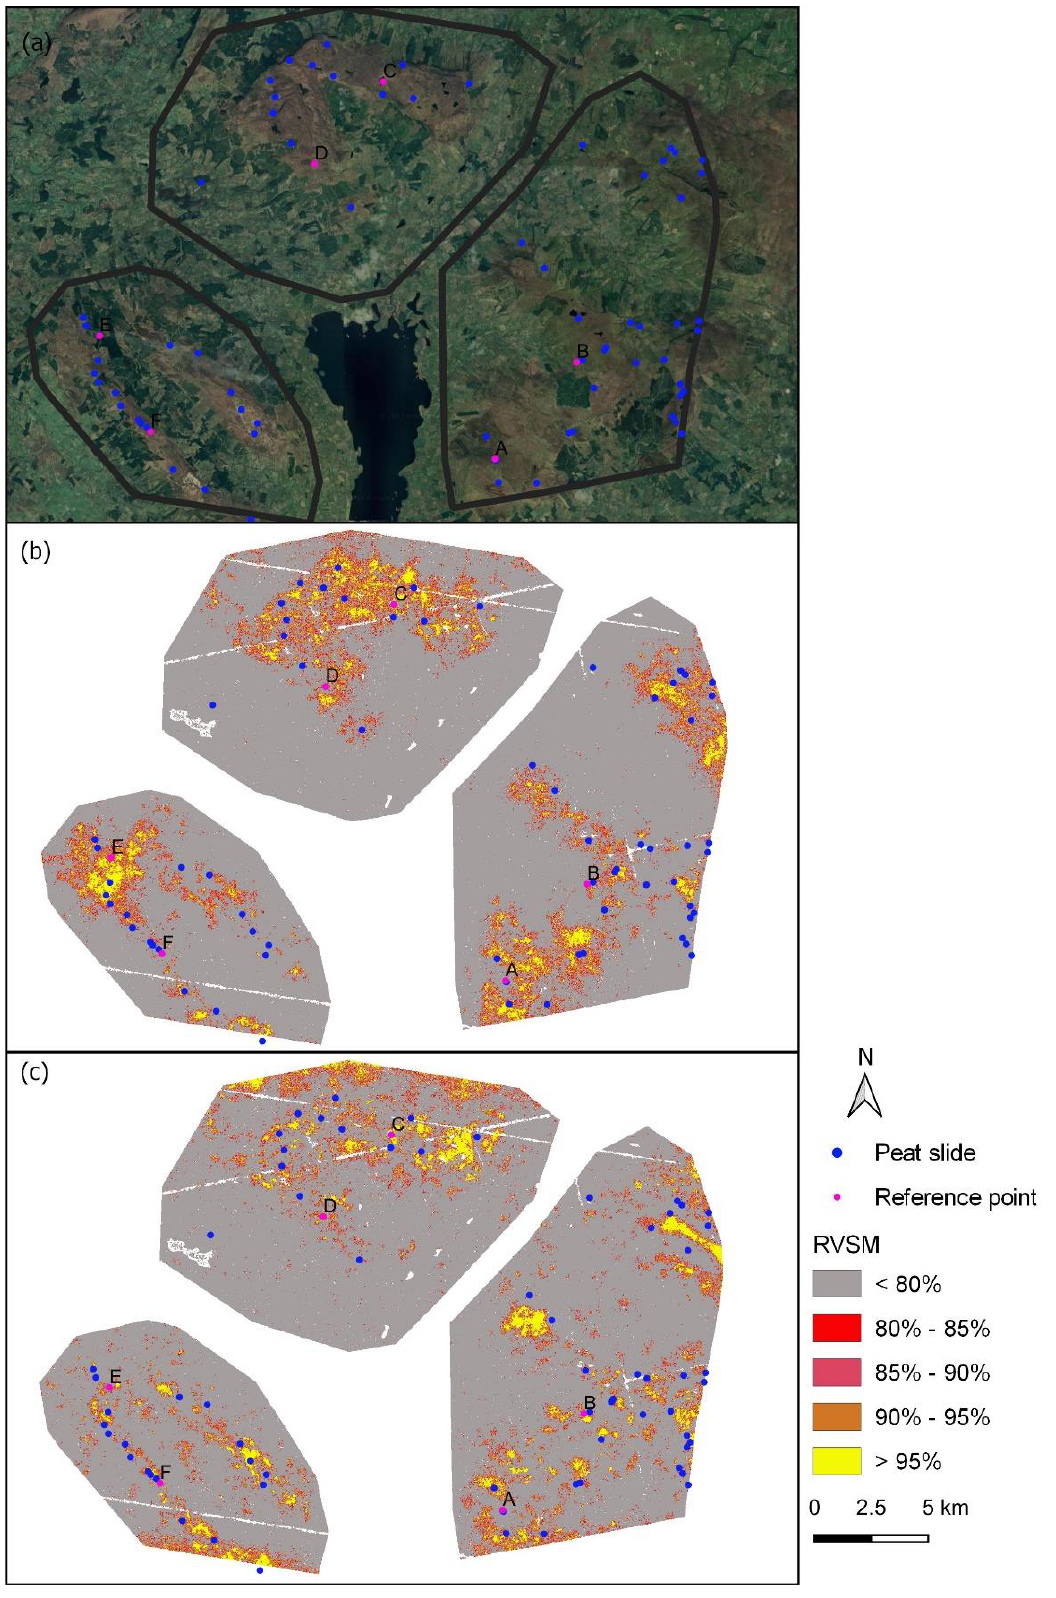
Figure 9. (a) Google Earth image showing the locations of historical peat slides (blue dots) in the upland study areas (Northern, Eastern and Western) around Lough Allen. The middle and lower panes show one- year RVSM of (b) standard APSIS data and (c) MSSA data, as percentiles. Areas around the reference points (A–F) are expanded for detailed comparison in Figure 10 (Geological Survey Ireland